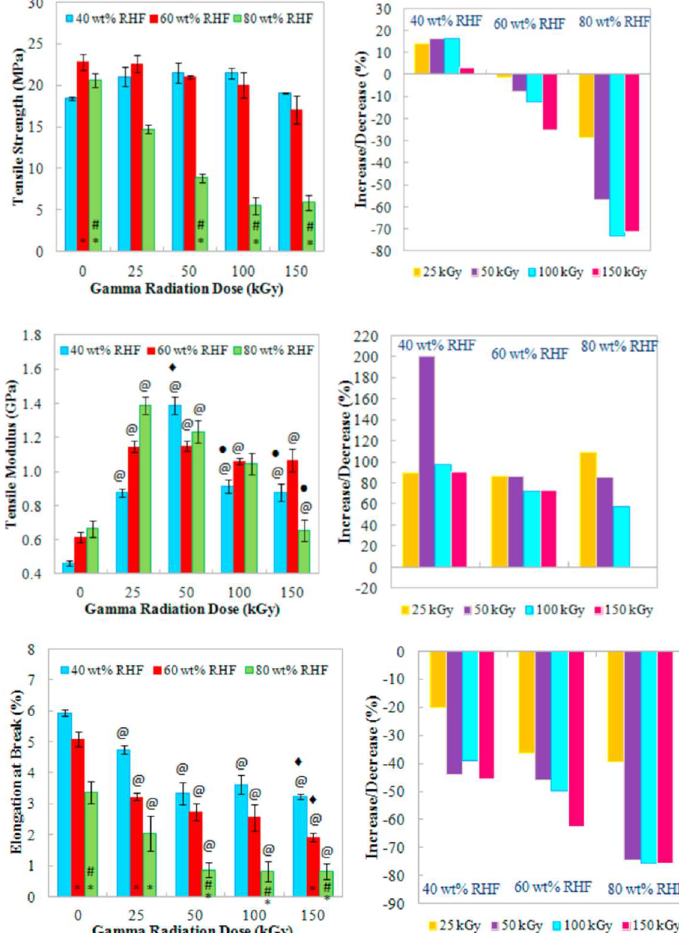
Figure 2. Tensile properties with applied gamma radiation. The symbols for gamma radiation * and # denotes 40 and 60 wt.% of rice husk fibers, for gamma radiation doses as compared to unirradiated of 25 and 50 kGy are denoted by ◆ and ● (reproduced with permission from [24] copyright 2021, Elsevier).